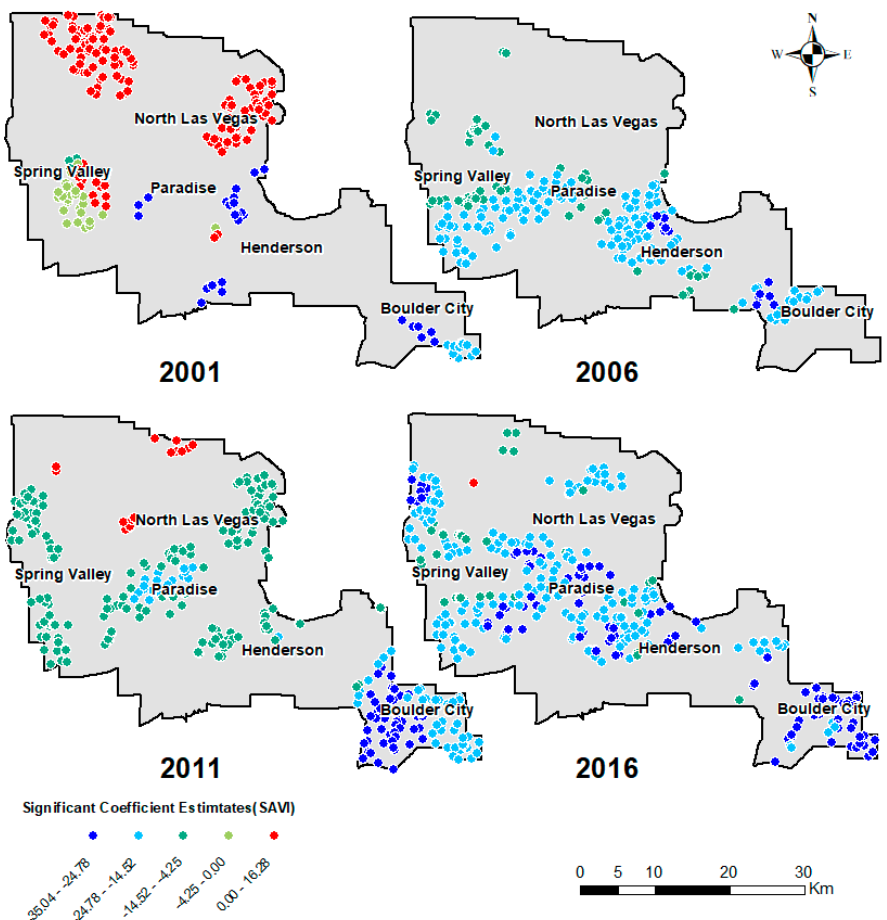
Figure 4. Spatial pattern of the soil adjusted vegetation index (SAVI) estimates from the geographically weighted regression (GWR) for four years in Las Vegas.